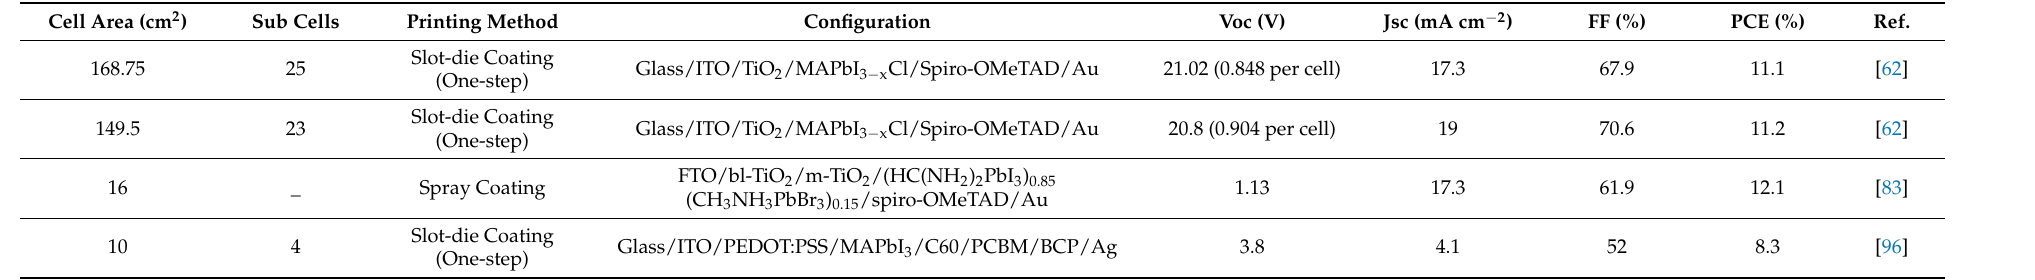
Table 3. Developments in the large area PSC fabrication.